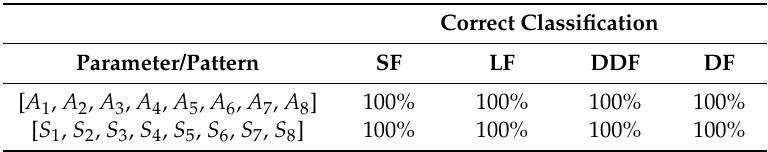
Table 3. Percent of correct